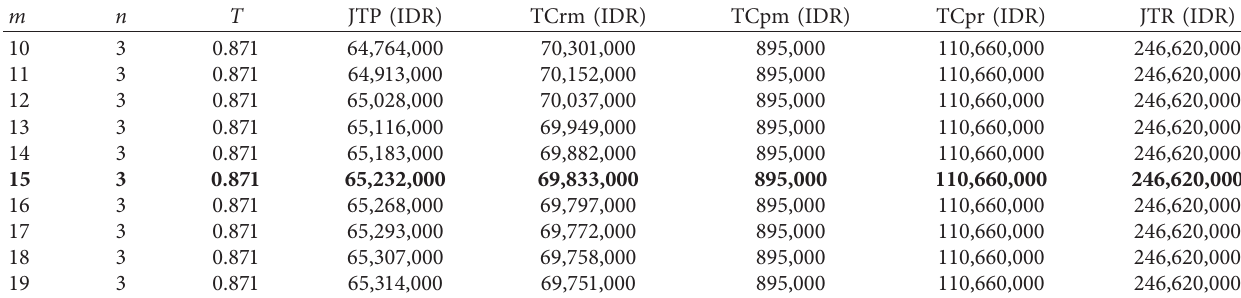
Table 3: Sensitivity analysis of the effect of m on cost, revenue, and profit.